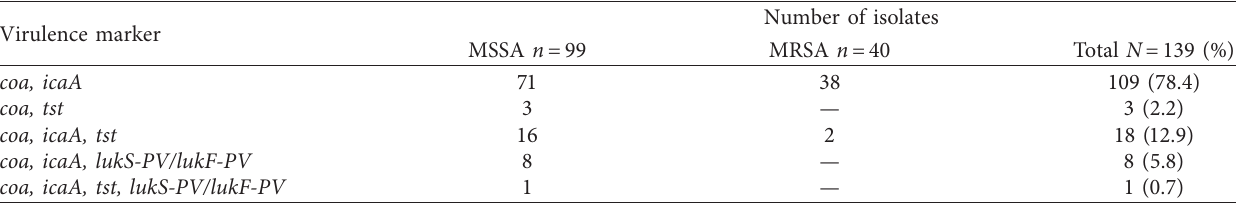
coa : coagulase; icaA : intercellular adhesion locus encoding N-acetylglucosaminyltransferase; tst : toxic shock syndrome toxin; lukS-PV and lukF-PV : β -pore- forming Panton-Valentine leukocidin. —: not detected.